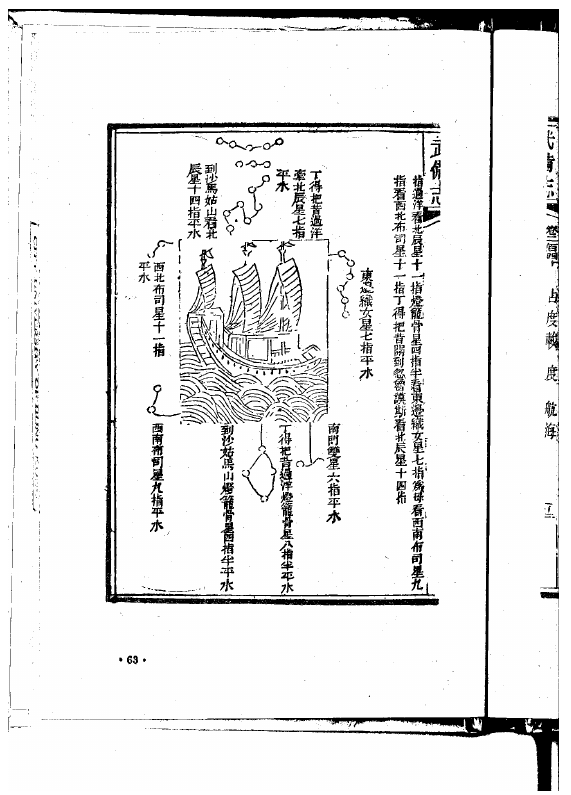
Figure 5. Big Dipper in the navigation maps. The Big Dipper is in the middle of the upper section. The navigation map also contains other asterisms that could help the sailors identify their location. Instructions were added next to each asterism, showing the sailors how to identify their location and direction based on the height of the stars. Zhenghe hanghai tu (The Navigation Maps of Zheng He’s Expedition) , p.